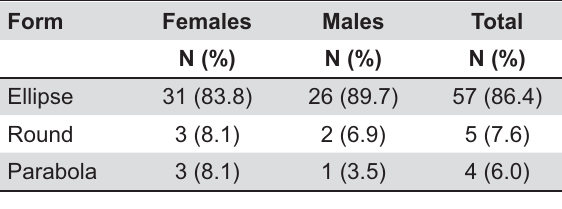
Table 3- Form of the dental arch (chi-square